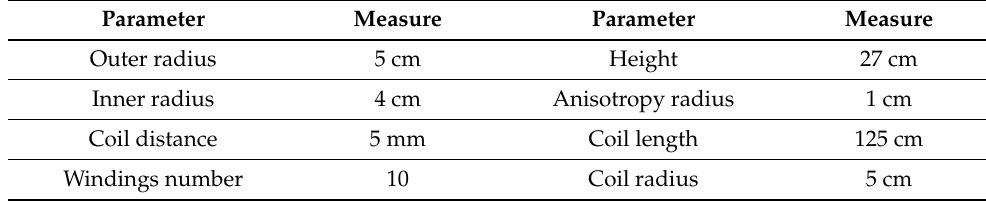
Table 1. Geometrical parameters for the coil, the pipe, and the anisotropy.